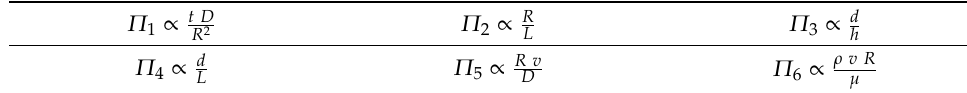
in Equation (23). Table A2. Dimensionless variables for the Dimensional